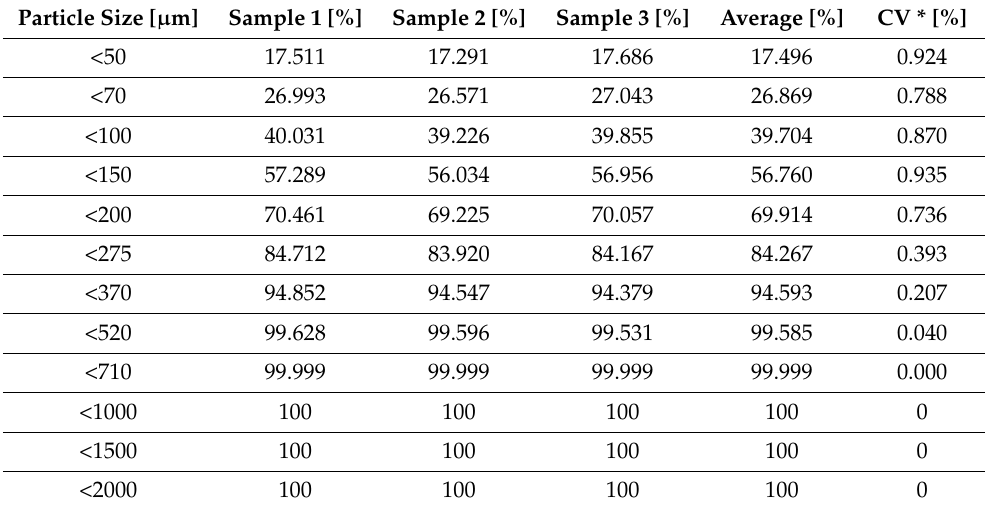
Table 5. Results of the second particle size distribution analysis in terms of cumulative